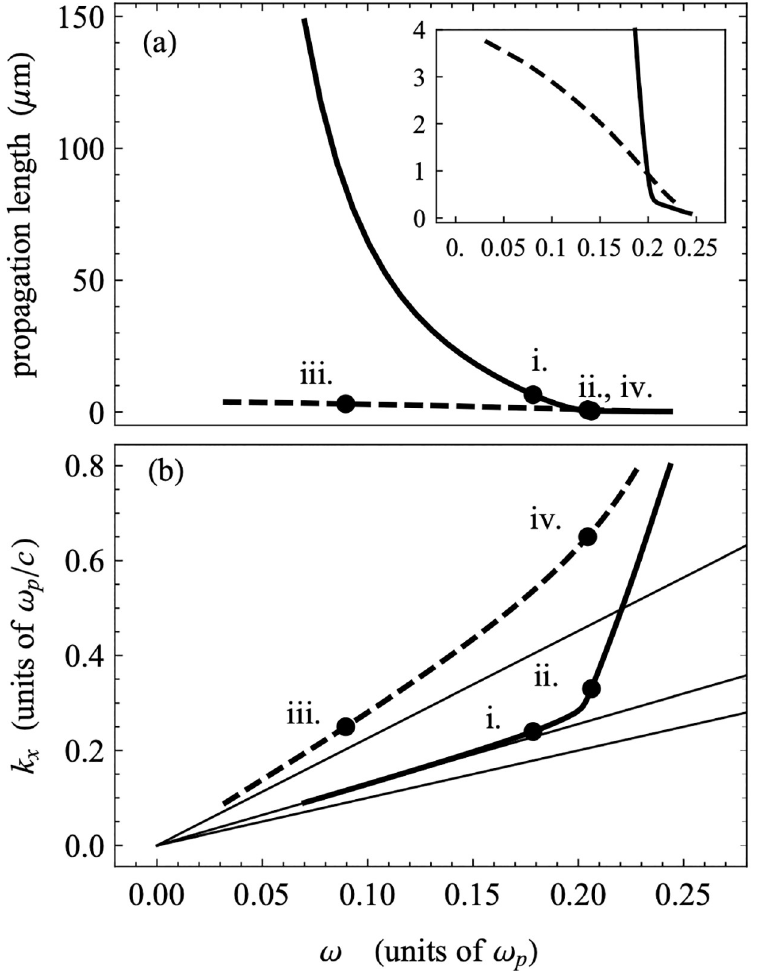
Fig 10. Propagation length and as a function of frequency. a) Propagation length as a function of frequency for the full range of frequencies, as well as focused on the low frequency region (inset); b) A portion of the dispersion displayed in Fig 6, focused on the experimentally relevant region. Several points (i-iv) are shown on both plots for